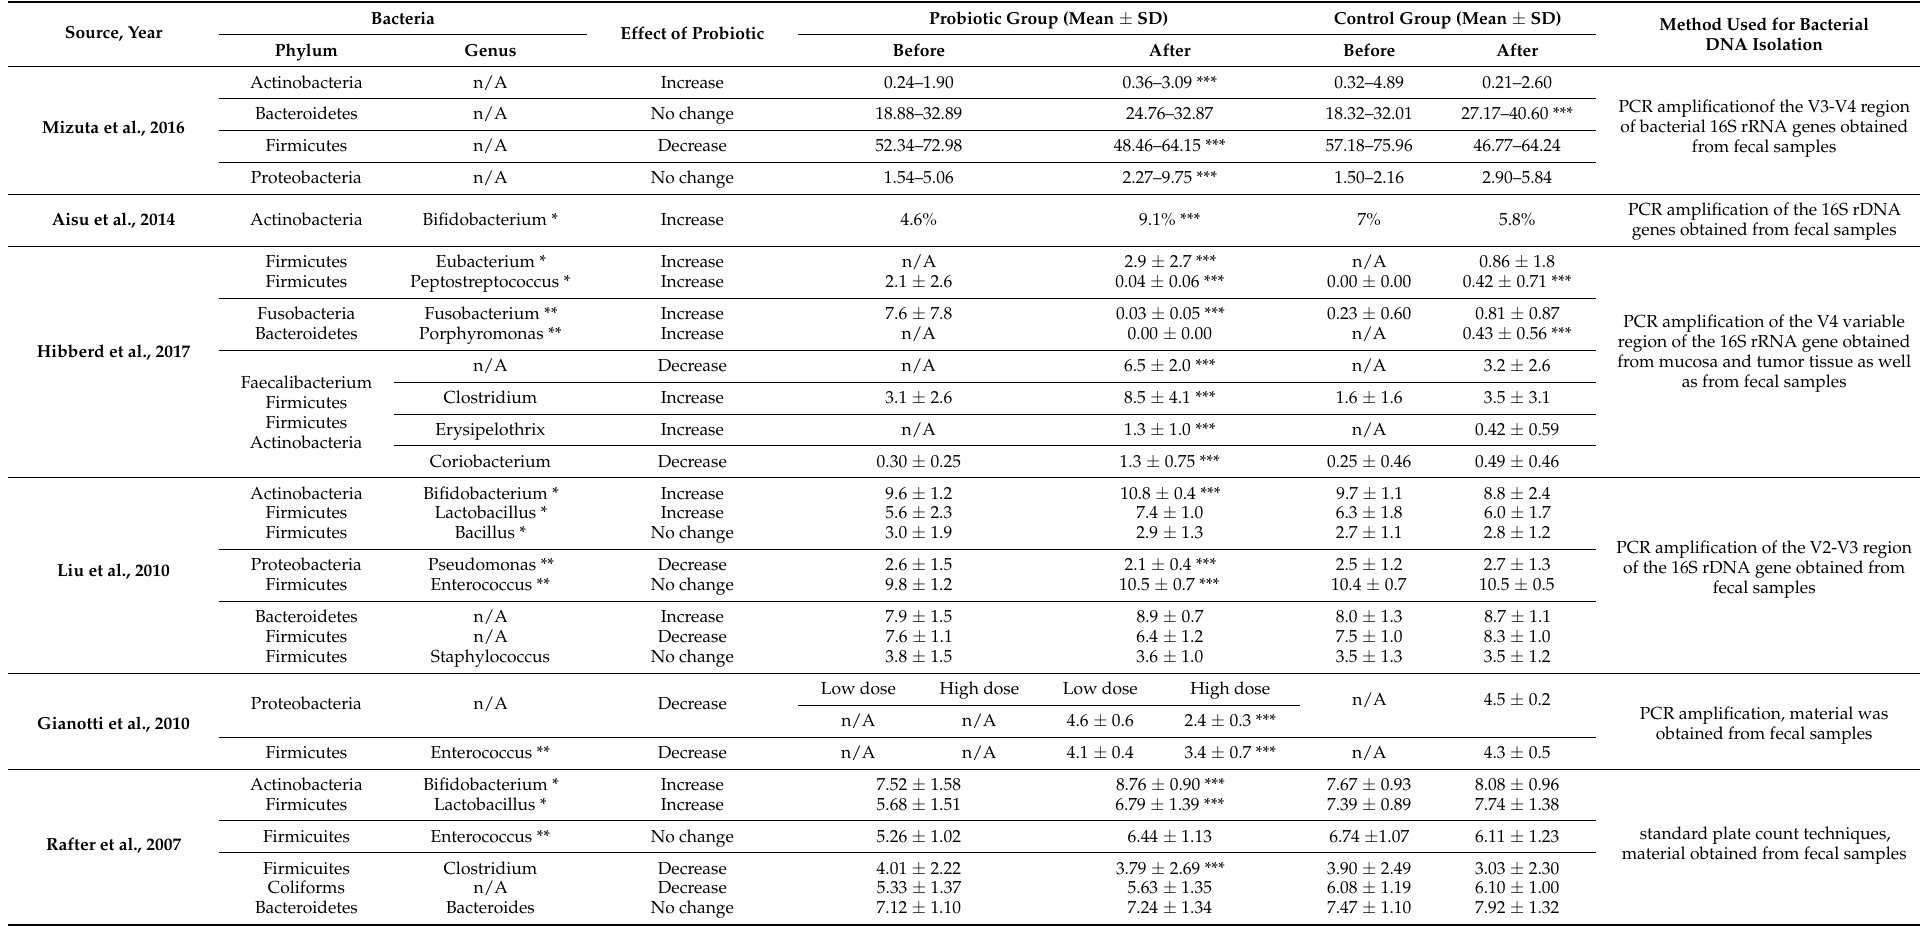
Table 3. Effect of probiotics on specific